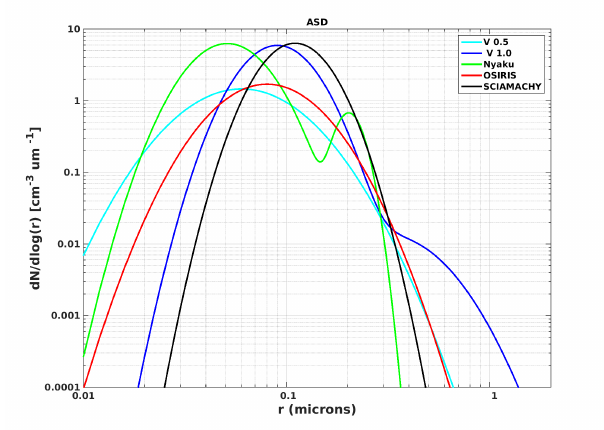
Figure 6. Illustration of the aerosol size distributions used in several recent LS aerosol extinction retrieval algorithms, including OSIRIS (V5), SCIAMACHY (V1.1), and OMPS (V0.5 and V1). The aerosol size distribution studied by Nyaku (2016) is also represented.